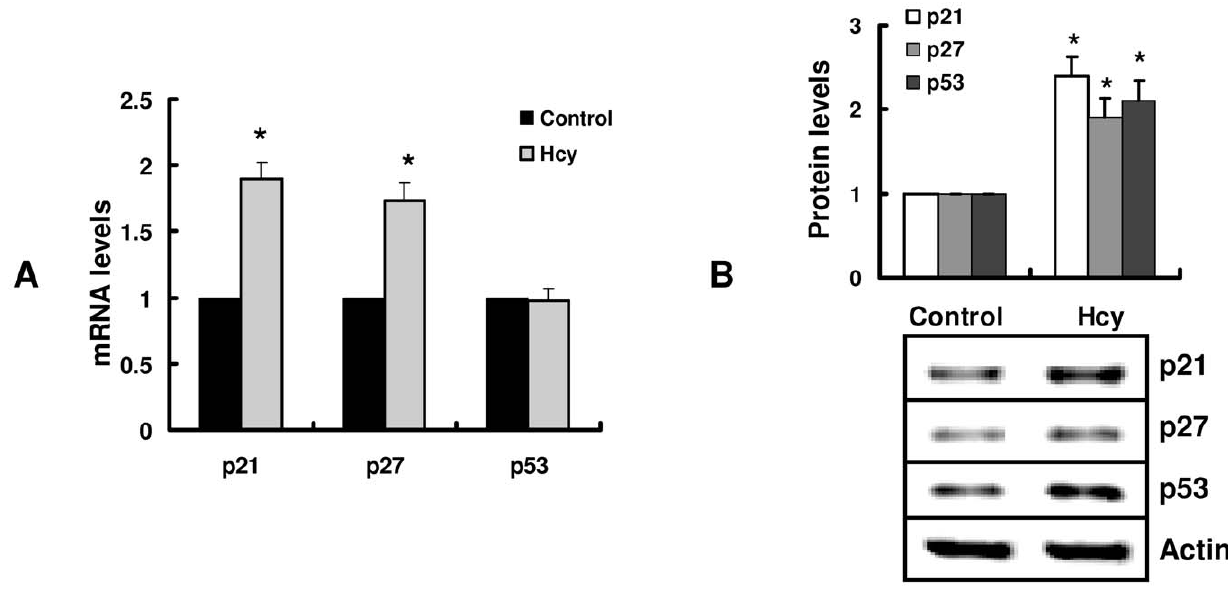
Figure 2. Homocysteine upregulates the expression of genes involved in transition of cell cycle. (A) Primary cultured hepatocytes were incubated with 1 mM of homocysteine (Hcy) for 8 h. The mRNA levels were detected by real-time PCR. All results are standardized to the levels of actin and are the means 6 SD of five experiments. * P , 0.05 versus control (without Hcy). (B) The proteins from hepatocytes were detected by Western blotting. The blot is representative of three independent experiments. The upper part shows quantification of immunoreactivity levels. The data are expressed as percent change from control. * P , 0.05 versus control (without Hcy).